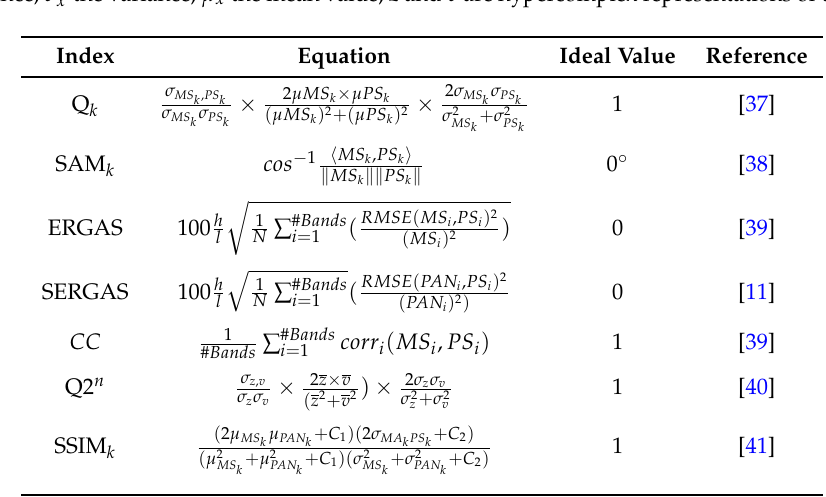
Table 2. Quality indices for the evaluation pansharpened images. k denotes the k -th band, σ x , y the co-variance, σ 2 x the variance, µ x the mean value, z and v are hypercomplex representations of the